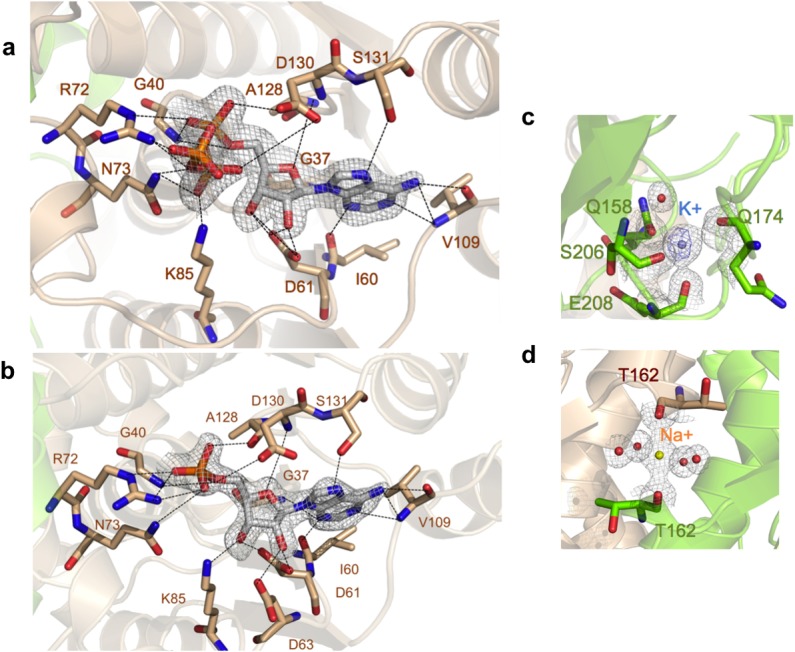
X-ray electron density maps of the ATP- and AMP-binding pocket and metal coordination spheres.
a Detailed view of the ATP-binding site of TcdA. Residues that interact with ATP are labeled and shown as sticks and atom colors (C atoms are in subunit colors, as in Fig. 1). 2mFo-DFc electron density map is depicted around the ATP substrate at 1.5 σ contour level. b Detailed view of AMP bound in the active site. Representation and electron density map as in (a). c, d Metal coordination spheres of K+ (c) and Na+ (d) cations. Interacting residues are labeled and shown as sticks in atom colors (C atoms are in subunit colors), and coordinating water molecules are shown as red spheres. Metals and their coordination spheres are shown in 2mFo-DFc electron density (grey). The anomalous Fourier map calculated from a long wavelength (1.89 Å) dataset at 2.4-Å resolution is shown for K+ (c) in purple; in contrast, Na+ has no anomalous signal at that wavelength, enabling the accurate discrimination between K+ and Na+ cations in the structure.